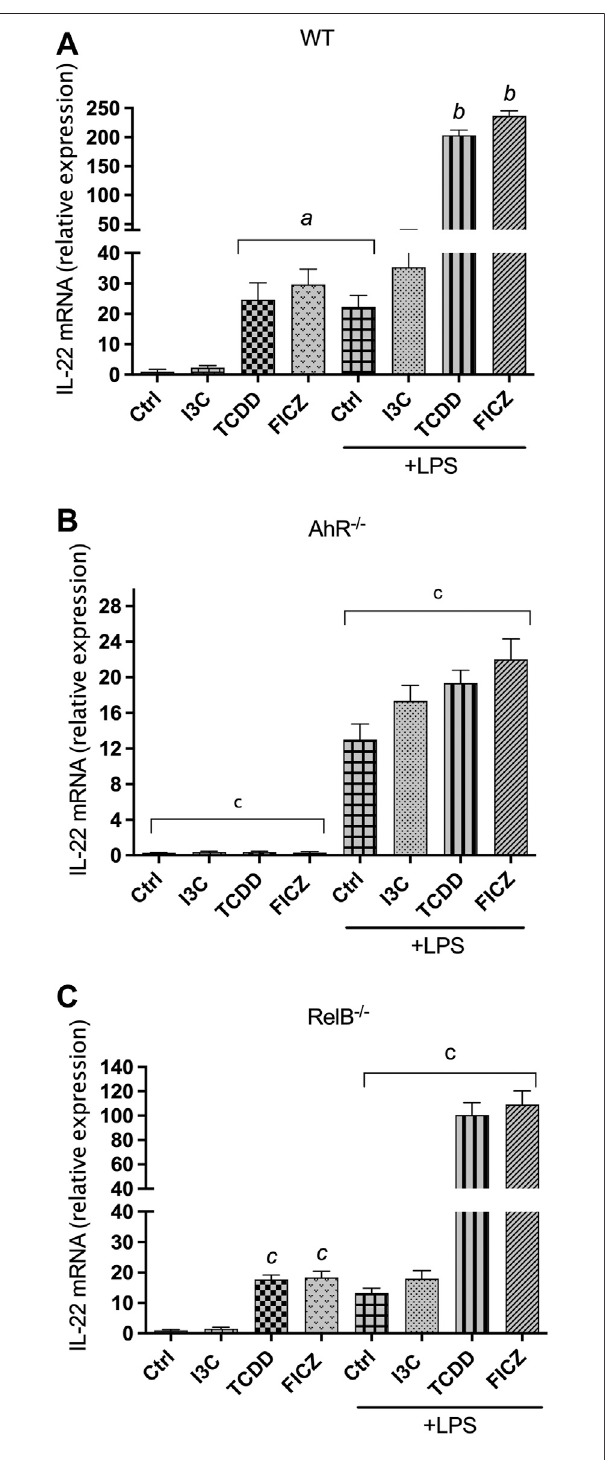
FIGURE 2 | Effect of AhR ligands on IL-22 mRNA expression. BMM derived from (A) WT, (B) AhR − / − , and (C) RelB − / − mice were treated with I3C (50 μ M),TCDD(1 nM),andFICZ(100 nM),innon-activatedandLPS-(1.0 μ g/ml) activated BMM for 24 h. The expression was corrected against the housekeepinggeneß-actin.Resultsarepresentedasmean ± SEMandthe y - axis